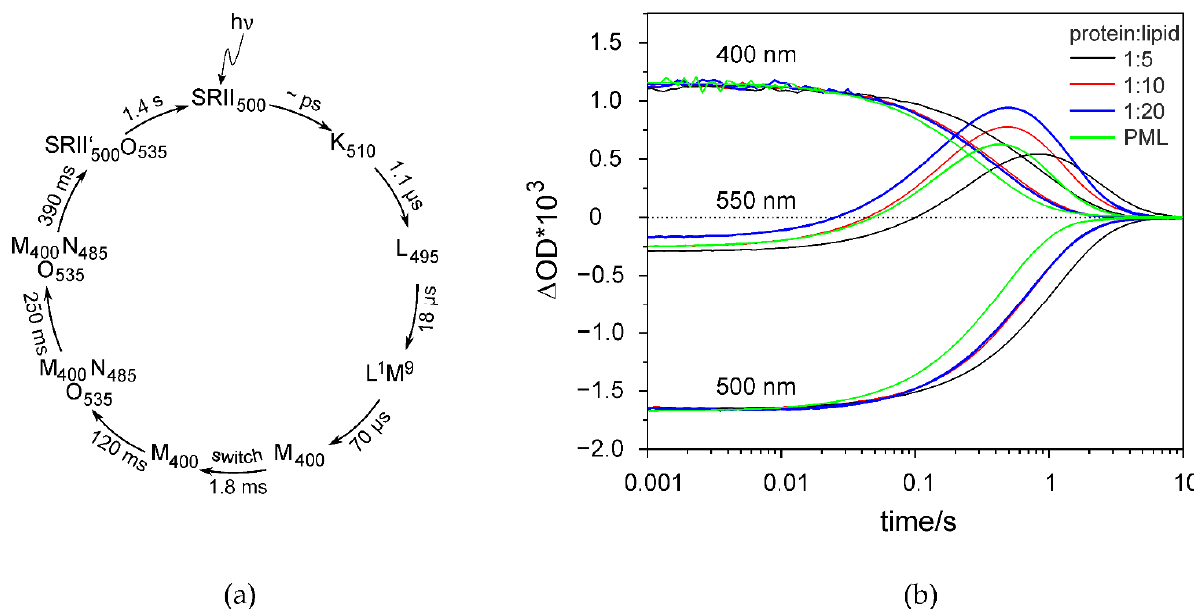
Figure 7. The photocycle of Np SRII in DIBMALPs depends on the protein-to-lipid ratio. ( a ) Np SRII photocycle characterized by transient changes in the optical absorption spectrum of the retinal chromophore. Subscripts indicate the wavelength of maximum absorption of the intermediates in nm (adapted from [51]). Time constants for the transitions between these intermediates are given according to the values for wildtype Np SRII reconstituted in purple membrane lipids [55]. ( b ) Transient optical absorption changes of Np SRII in DIBMALPs (DIBMA/lipid ratio 1:1) were recorded at 400 nm (M- intermediate), 500 nm (initial state) and 550 nm (O-state). The Np SRII-to-lipid ratio was varied, 1:5 (black), 1:10 (red) and 1:20 (blue). The fitted exponential curves are exemplarily shown for 1:20 as thin lines, which are indistinguishable from the measured transients. Maximum values of transients for 400 and 500 nm were normalized to the corresponding values of sample 1:20. For comparison, the traces of Np SRII in native purple membrane lipids (PML) are given (green) (data taken from [38]).